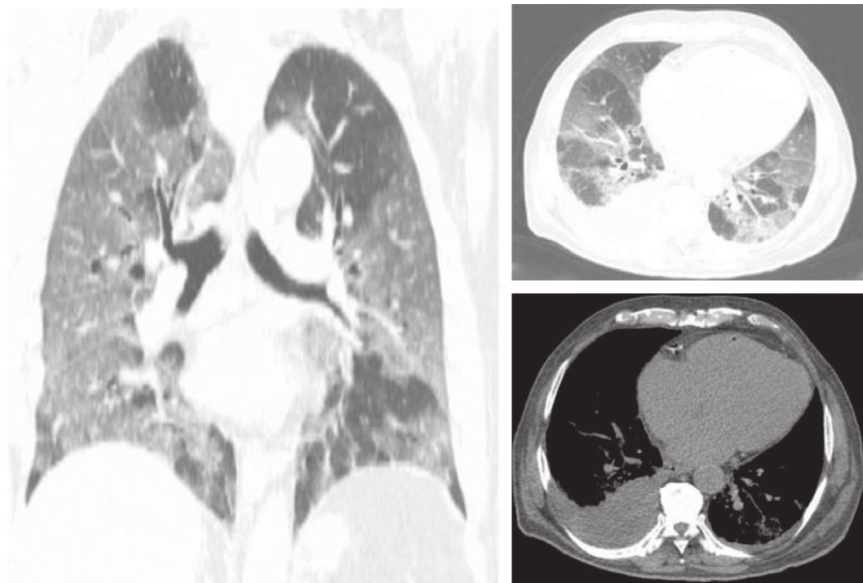
Figure 2: A 76-year-old male patient with diabetes deceased due to COVID-19. Chest CT scan ((a) coronal view, (b) axial view-lung window, and (c) axial view-mediastinal window) showed predominancy of ground-glass opacity (GGO) with the bilateral and diffuse distribution. Pulmonary involvement (PI) and PI density scores were 16 and 3.2, respectively. Additional findings included cardiomegaly and bilateral pleural effusion. He was considered a high-risk patient.